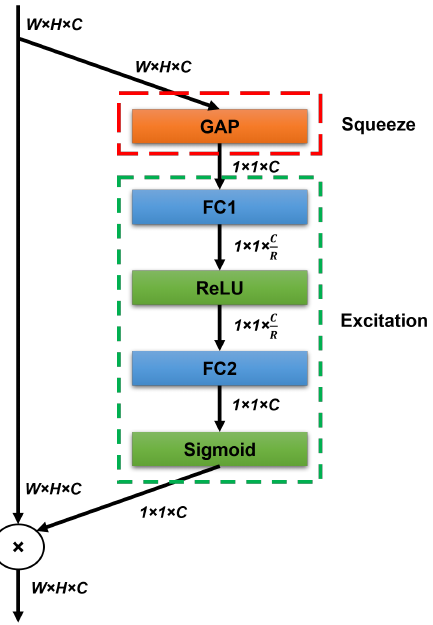
Figure 2. Squeeze-and-excitation attention module